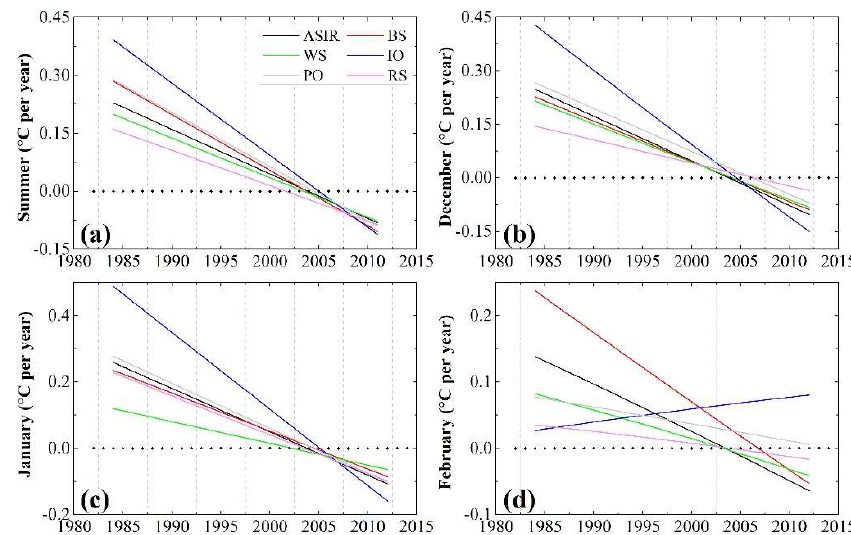
Figure 9. The same as Figure 7 but for SST ( ° C per year). Table 9. As in Table 5 but for SST.